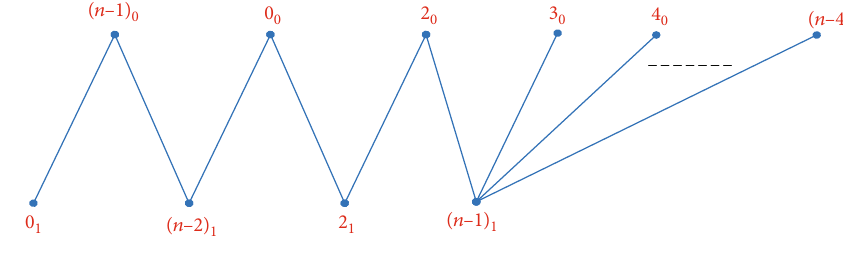
Figure 19: An orthogonal labeling for C